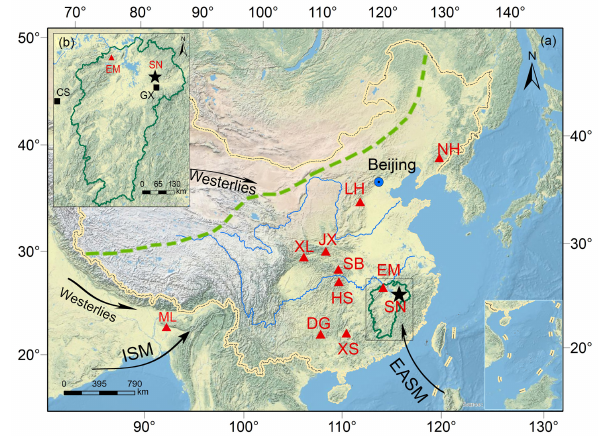
Figure 1. Location of Shennong Cave (SN, black star) and other caves mentioned in the paper. Panel (a) is an overview topographic map and Jiangxi Province is framed by the green line. Red trian- gles show the locations of published stalagmite records. NH: Nu- anhe Cave (Tan, 2005), LH: Lianhua Cave (Dong et al., 2015), JX: Jiuxian Cave (Cai et al., 2010), XL: Xianglong Cave (Tan et al., 2018a), SB: Sanbao Cave (Dong et al., 2010), HS: Heshang Cave (Hu et al., 2008), EM: E’mei Cave (Zhang et al., 2018), XS: Xiang- shui Cave (Zhang et al., 2004), DG: Dongge Cave (Wang et al., 2005), ML: Mawmluh Cave (Berkelhammer et al., 2012). Black arrows denote the directions of the East Asian summer monsoon (EASM), Indian summer monsoon (ISM) and westerlies, which affect the climate in China. The green dashed line indicates the limit of the modern East Asian summer monsoon. Panel (b) is an enlarged map showing the locations of Shennong Cave, the Guixi meteorological station (GX) and the GNIP station in Chang- sha (CS). The base map is the Natural Earth physical map at 1.24km per pixel for the world (data source: US National Park Ser- vice, http://goto.arcgisonline.com/maps/World_Physical_Map; last access: 11 February 2017). For interpretation of the references to colors in this figure legend, the reader is referred to the web version of this article.